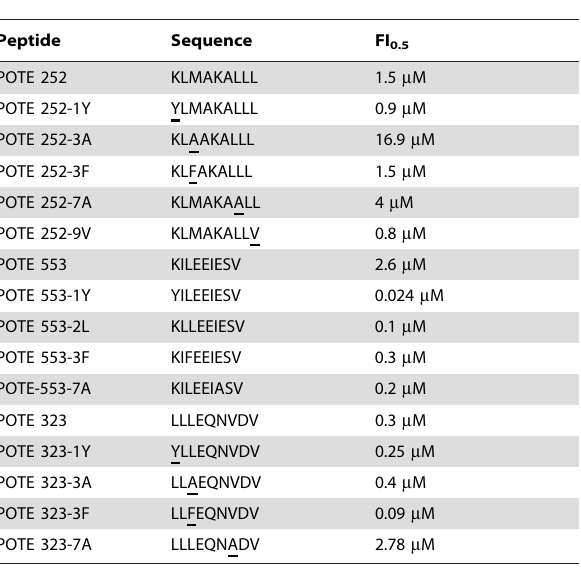
Table 2. List of modified peptides from POTE protein.